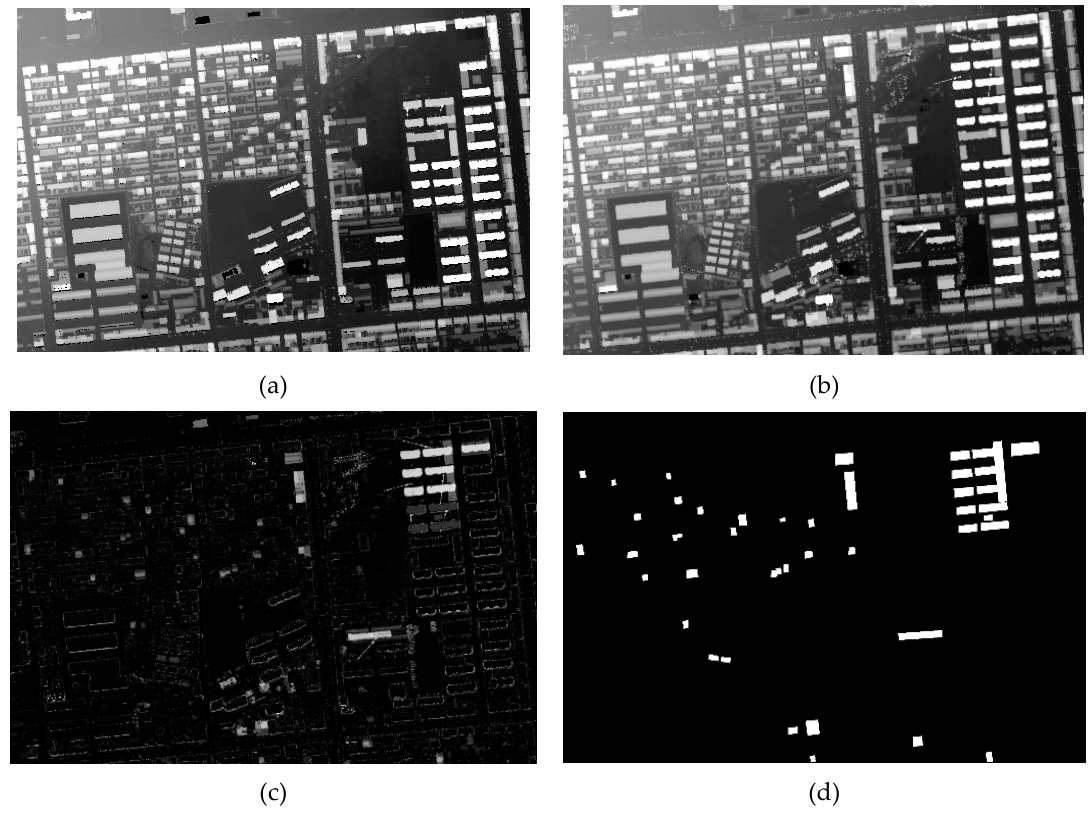
Figure 1. Experimental data: ( a ) digital surface models (DSM) obtained in 2017, ( b ) DSM obtained in 2018, ( c ) D-DSM, and ( d ) ground reference map.